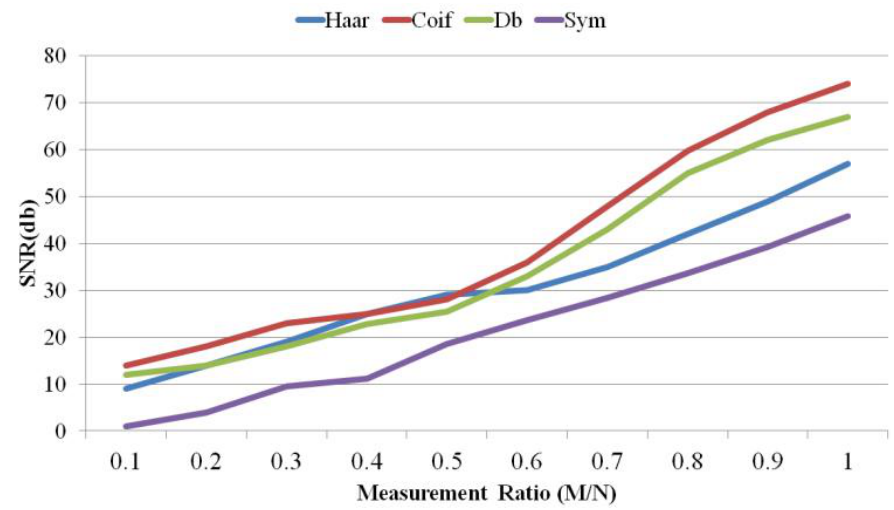
Figure 10. Comparing Haar WT, Symlet WT, Coiflet WT, and Daubichi WT in terms of SNR.